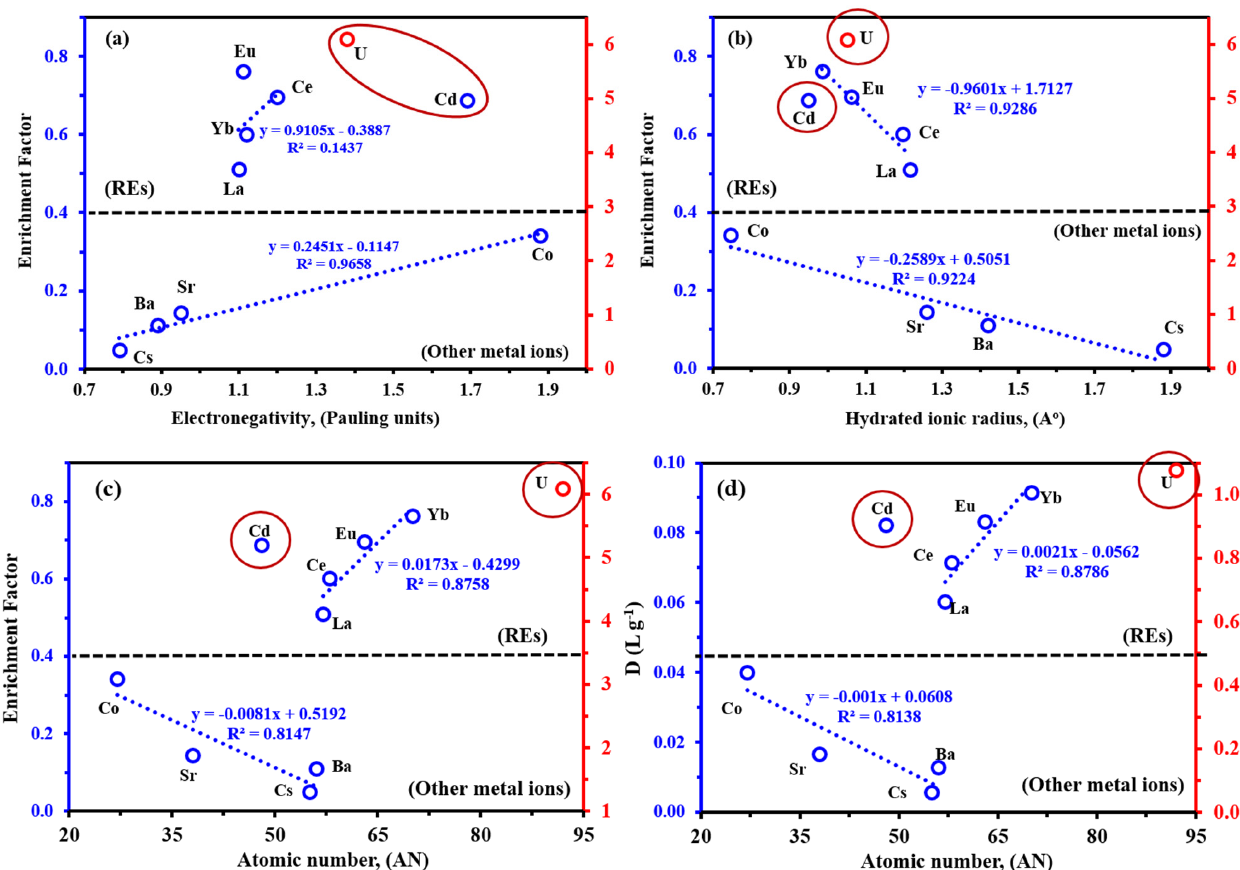
Figure 7. The distribution of the selected metal ions in pregnant liquor, treated liquor, and the Cys- sorbent (molar percentages).